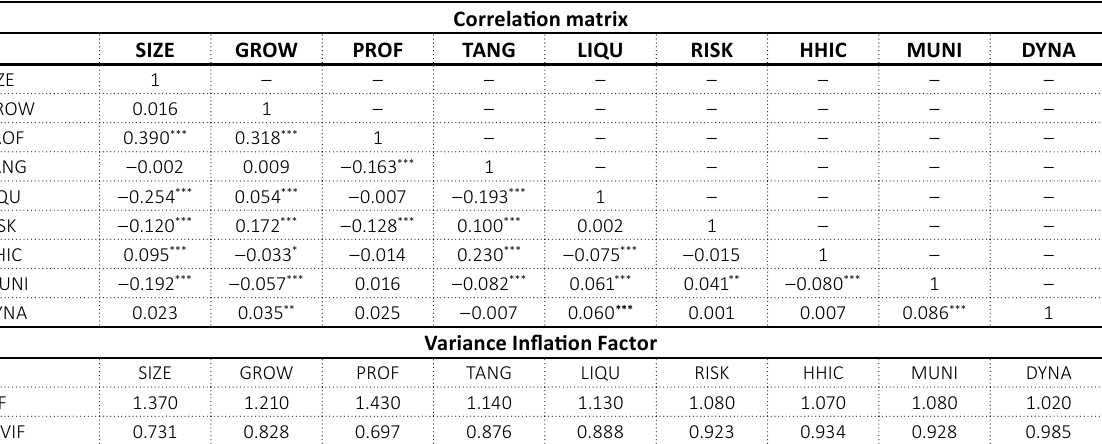
Table 2. Correlation matrix and VIF